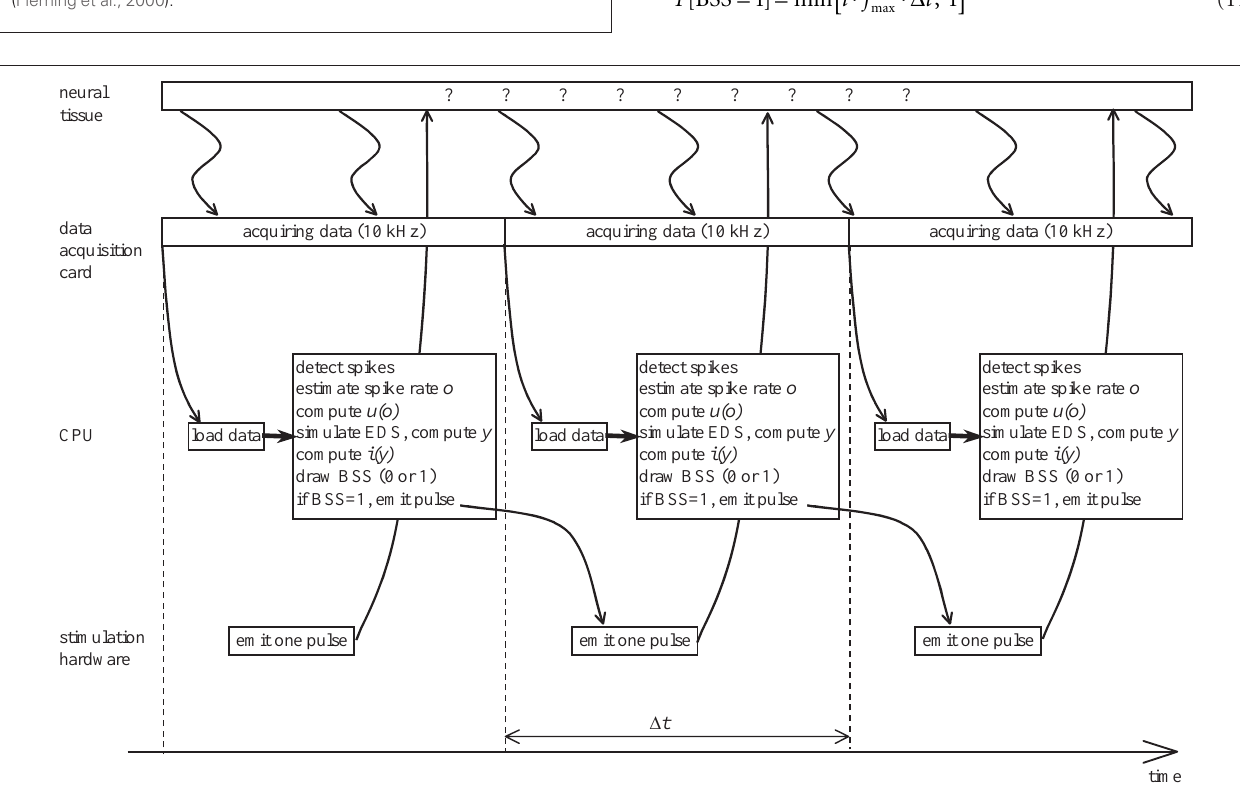
FIGURE 4 | Input interface mapping (Eq. 9). This particular shape of the input interface mapping was chosen to represent the light intensity signal as a function of robot orientation in the experiments that use the same brain–machine interface setup with a mobile robot as the external device (Fleming et al., 2000).